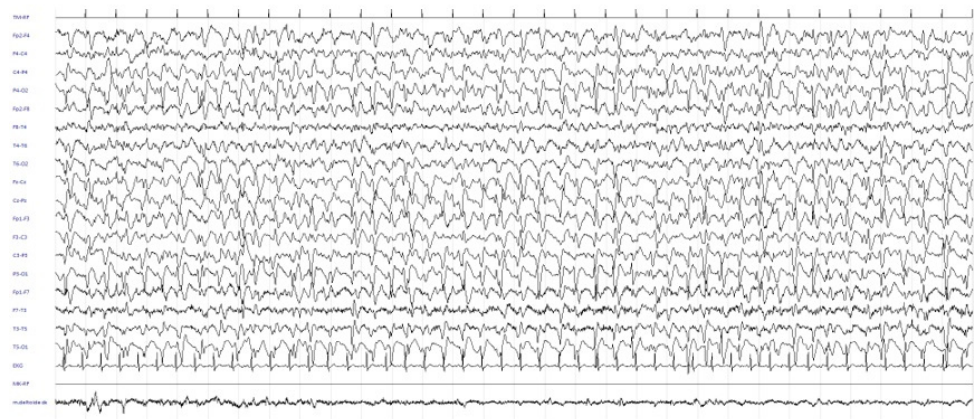
Figure 3. Recurrent paroxysmal diphasic and triphasic abnormalities in the right posterior regions with diffusion to the contralateral homologous regions, sometimes in a periodic pattern .